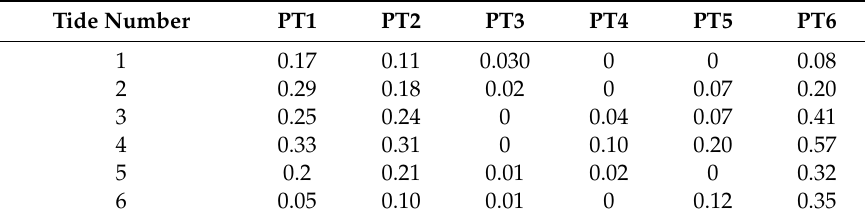
Figure 13. High tide significant wave heights, presented as percentages of the maximum measured for each high tide, for the 6 pressure transducers (PTs), PT1 in the west to PT6 in the east: ( a ) deployment 1; ( b ) deployment 2. Table 3. Longshore significant wave height reductions (m) compared to maximum measured significant wave height for deployment 1.